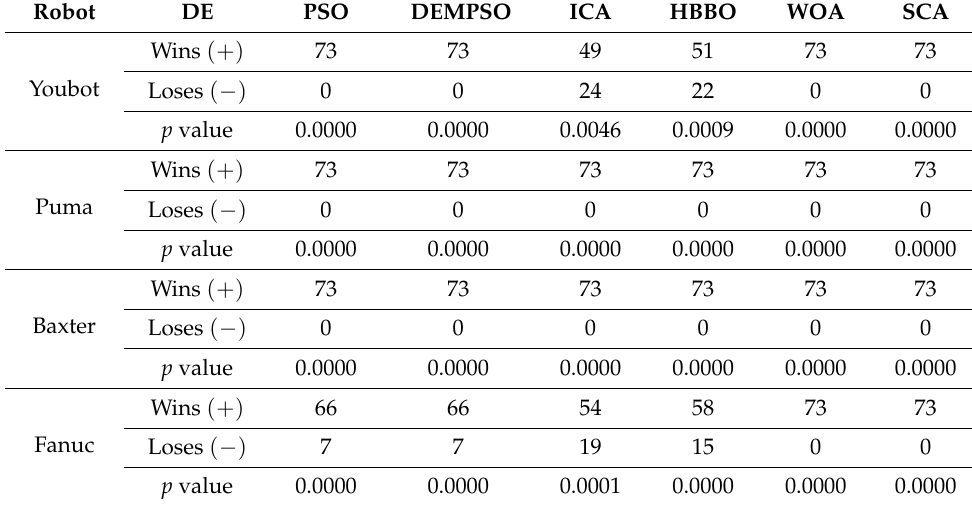
Table 9. Sign test results for the objective function for the lemniscate